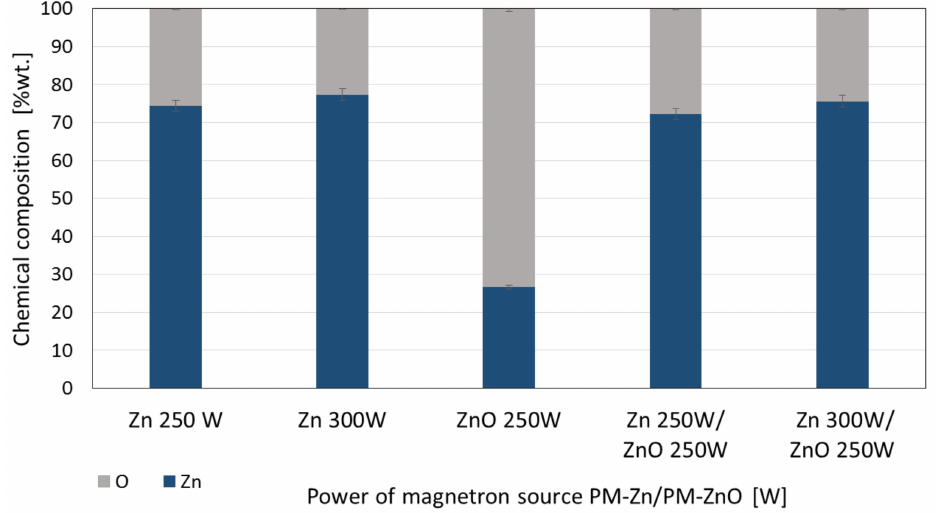
Figure 2. The comparison of mass weight percentage elements (% wt.) for three types of coatings: one-component Zn and ZnO coatings and two-component Zn/ZnO coatings deposited by different magnetron power